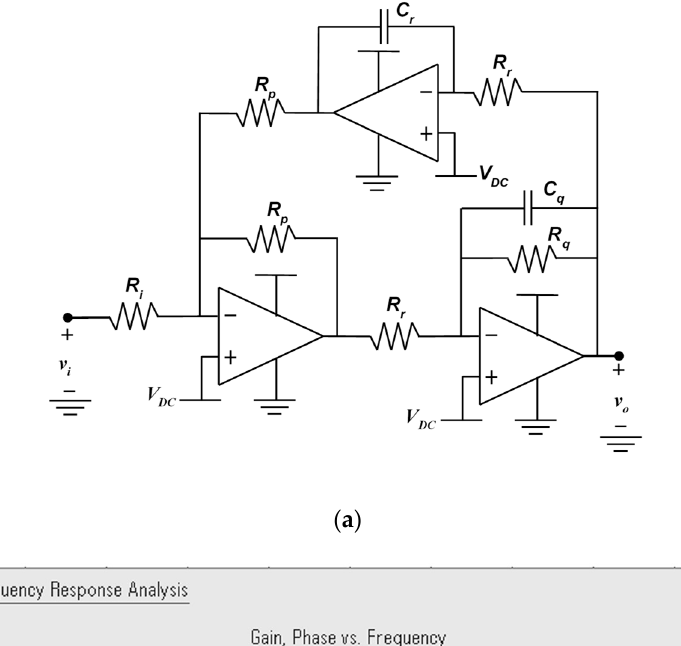
Table 2. Components of the reference-frequency band-pass filter in Figure 5.